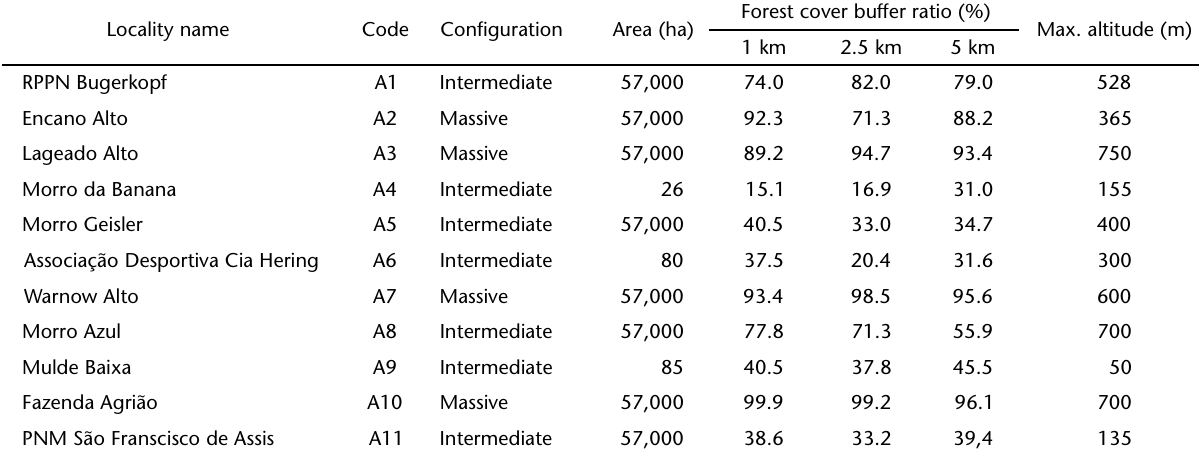
Table I. Description of the characteristics of the remnants of the Atlantic Forest of the hydrographic basin of the Itajaí River, Santa Catarina, evaluated for the composition of mixed-species bird flocks. Locality name